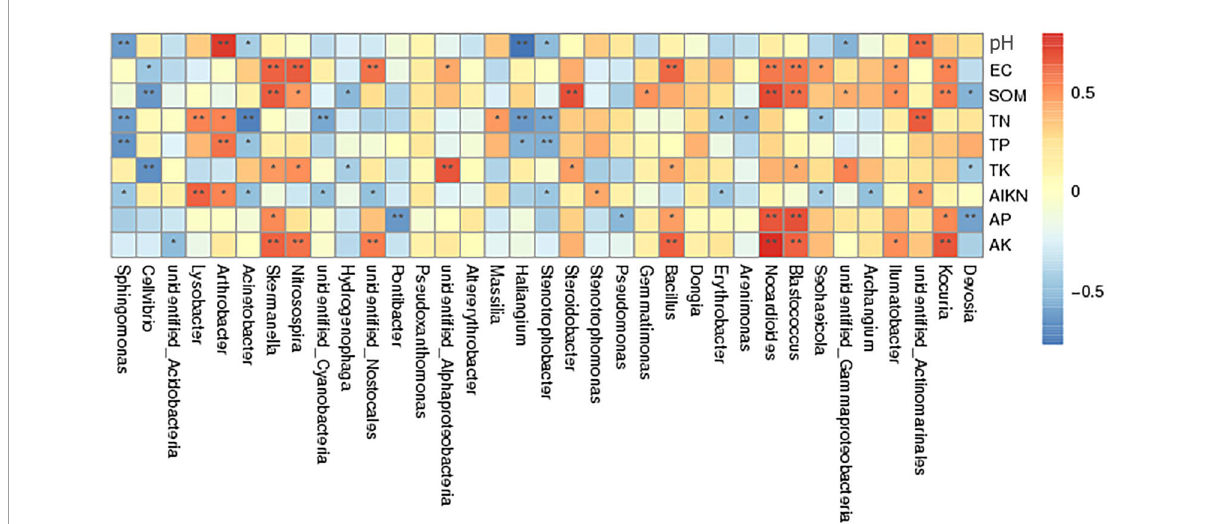
FIGURE7 Spearman’s correlation analysis of soil bacterial community and soil physicochemical properties under different treatments. CK, no fertilizer; CF, chemical fertilizers (conventional dosage for this region); BF, balanced fertilizer (70% of total chemical fertilizer); BF + OF1, BF + OF2, and BF + OF3, balanced fertilizer plus 3,000, 6,000, and 12,000 kg.ha − 1 bio-organic fertilizer, respectively. **Correlation is significant at the 0.01 level; *correlation is significant at the 0.05